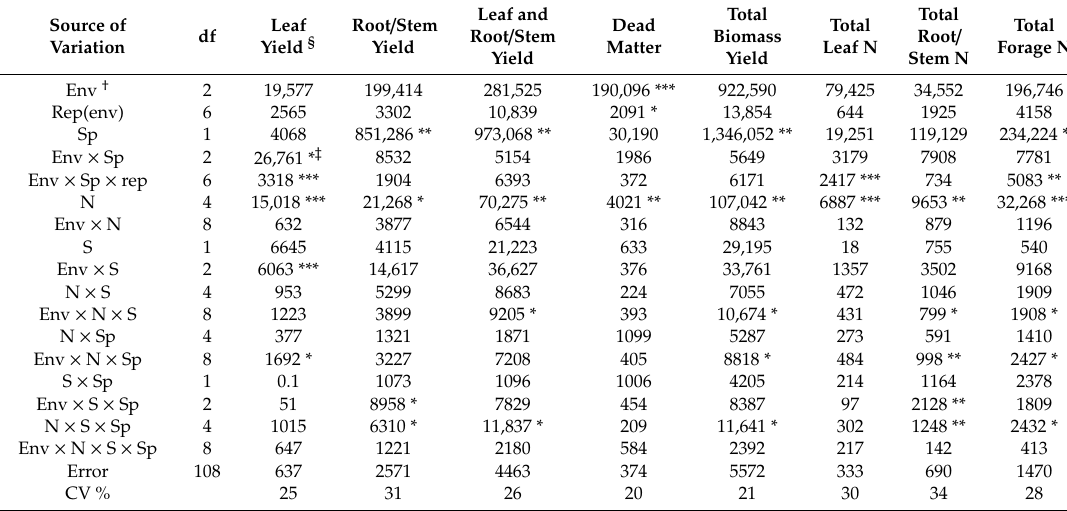
† Env = Environment, Rep = Replicate, Sp = Species and cultivars. ‡ *, **, *** Significant at 0.05, 0.01, and 0.001